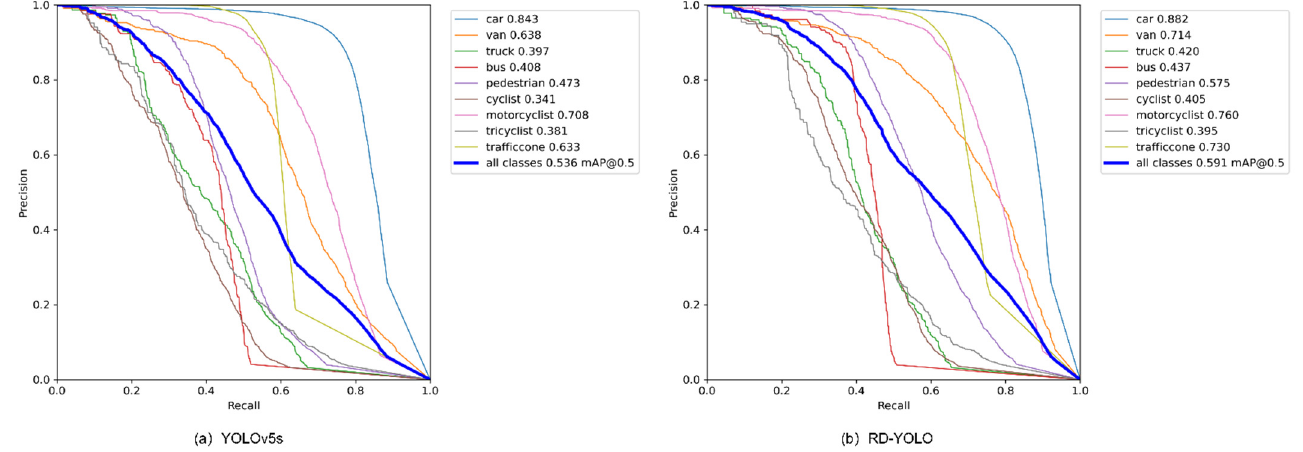
Figure 12. PR-Cure comparison of YOLOv5s and RD-YOLO.